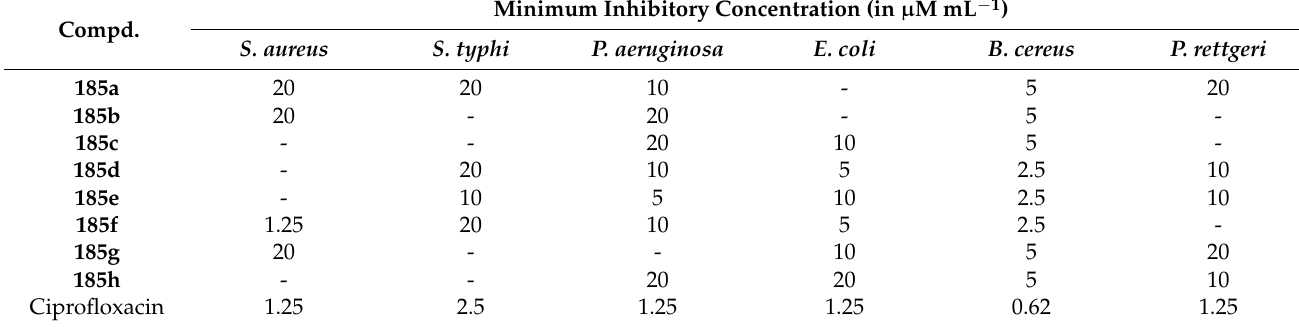
Figure 19. Structures of compounds 193 and 194 [81]. Figure 18. Structures of compounds 184 and 185a – 185h [78]. Figure 18. Structures of compounds 184 and 185a – 185h [78]. El-Deen et al. [82] reported the synthesis of the pyridothienopyrimidine derivatives Table 12. MIC values of 4H-pyrimido[2,1-b]benzothiazoles 185a – 185h [79]. ( S. aureus , B. Subtilis , B. cereus ) and Gram-negative ( E. coli , S. typhimurium , P. aeruginosa )